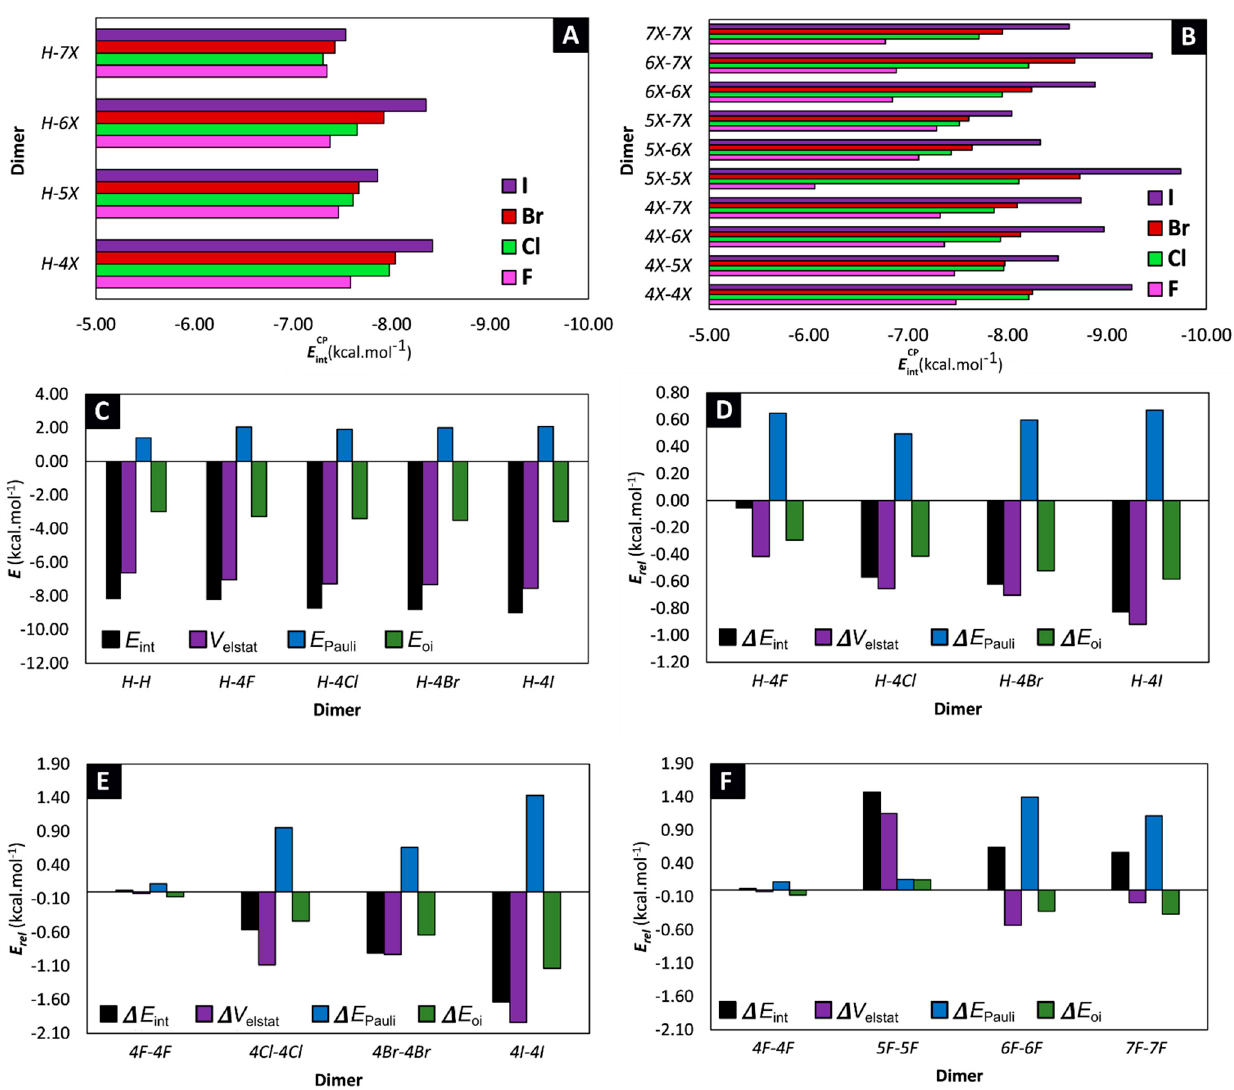
Figure 4. ( A , B ) Bar charts of 𝑬 𝒊𝒏𝒕𝑪𝑷 organized per type of dimer. ( C ) Results of the energy decomposition analysis displayed for the parent H-H dimer and H-4X dimers. ( D – F) Results of the energy decomposition analysis, expressed relative to the parent H-H dimer and displayed for the ( D ) H-4X , ( E ) 4X-4X and ( F ) aF-bF dimers. All results are displayed in kcal.mol − 1 , although for clarifying purposes a different scale for the y-axis is used for plots c, d and e and f.